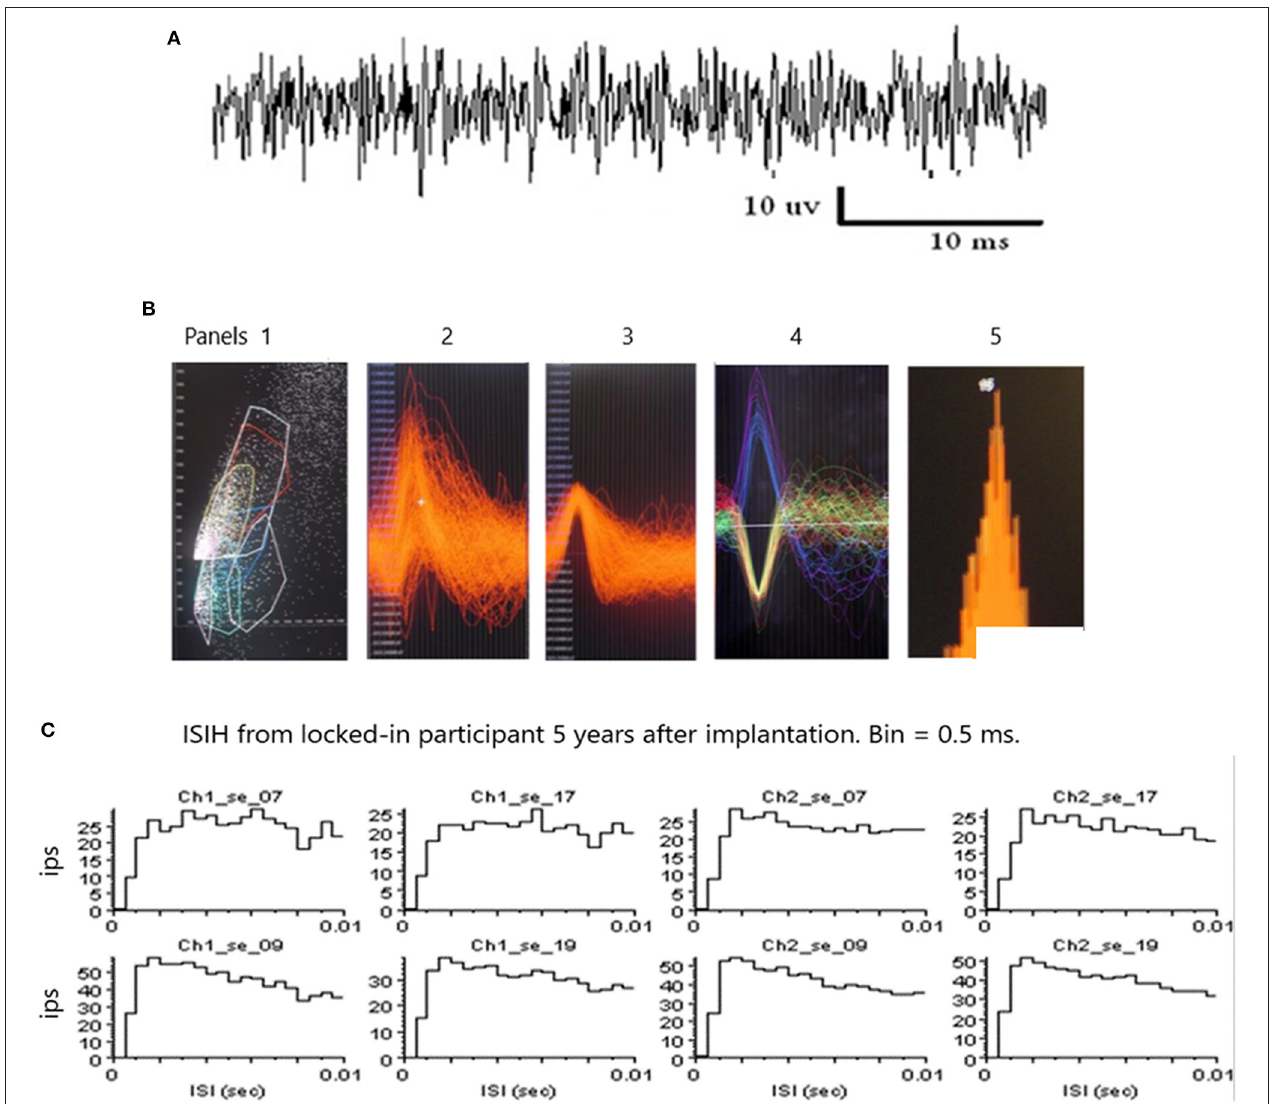
FIGURE 4 | (A) An example of continuous data stream from one electrode over a 40ms timebase. (B) Panel 1 illustrates clusters of waveform features (height and width) and a “convex hull” is drawn around a group of dense features. Amplitude is on the abscissa and width on the ordinate. The lower right convex hull surrounds slow firing units. The waveforms emanating from this “convex hull” are displayed in panel 2. Note the white marker that is used to separate the higher amplitude waveforms from the lower amplitude waveforms. Waveforms are separated by placing the marker above and below the peak to remove possible noise, as shown in panel 3. A selection of various waveforms is illustrated in panel 4, some depolarizing in the upward direction and some depolarizing in the lower direction due to the opposite polarity of the recording wires, as shown in Figure 1 . The amplitude of the upward depolarizing waveform from baseline is 80 mVs and the time base is one ms. An example of an auto-correlogram of one single unit is shown in panel 5. (C) Inter Spike Interval Histograms. Examples of fast firing units indicating the 0.5ms gap at origin. Slow units will have a false gap and are not shown. Ips, impulses per second. Units taken from both channels of data (ch1_se_07; ch2_se_07). 10ms time